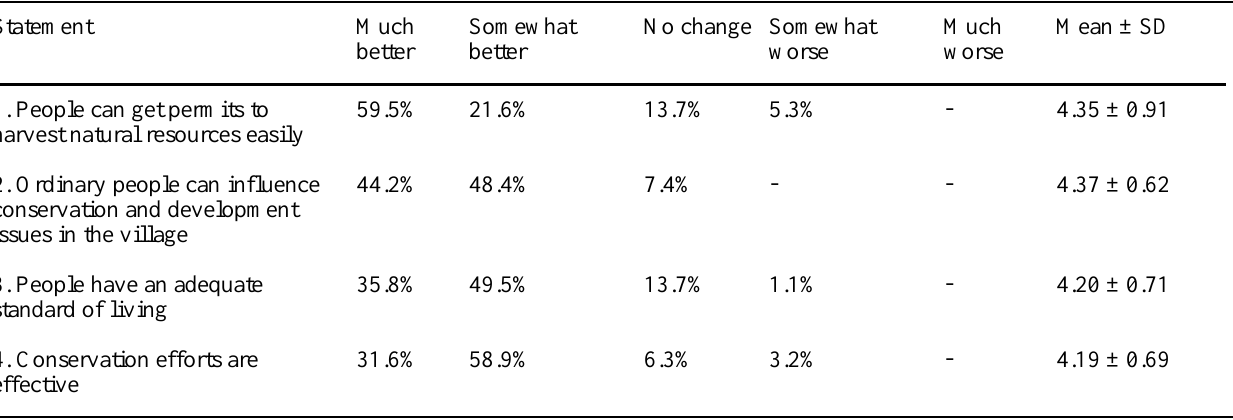
Table 3 . Summary results of the four indicators used to measure the efficiency of the conservation institution in the Annapurna Conservation Area. Conservation Area Management Committee members were asked to rate on a 5-point scale if the following things are better or worse now than they used to be 10 years ago: much better =5, somewhat better = 4, no change = 3, somewhat worse = 2, much worse = 1. (Source: authors’ interview data; n =